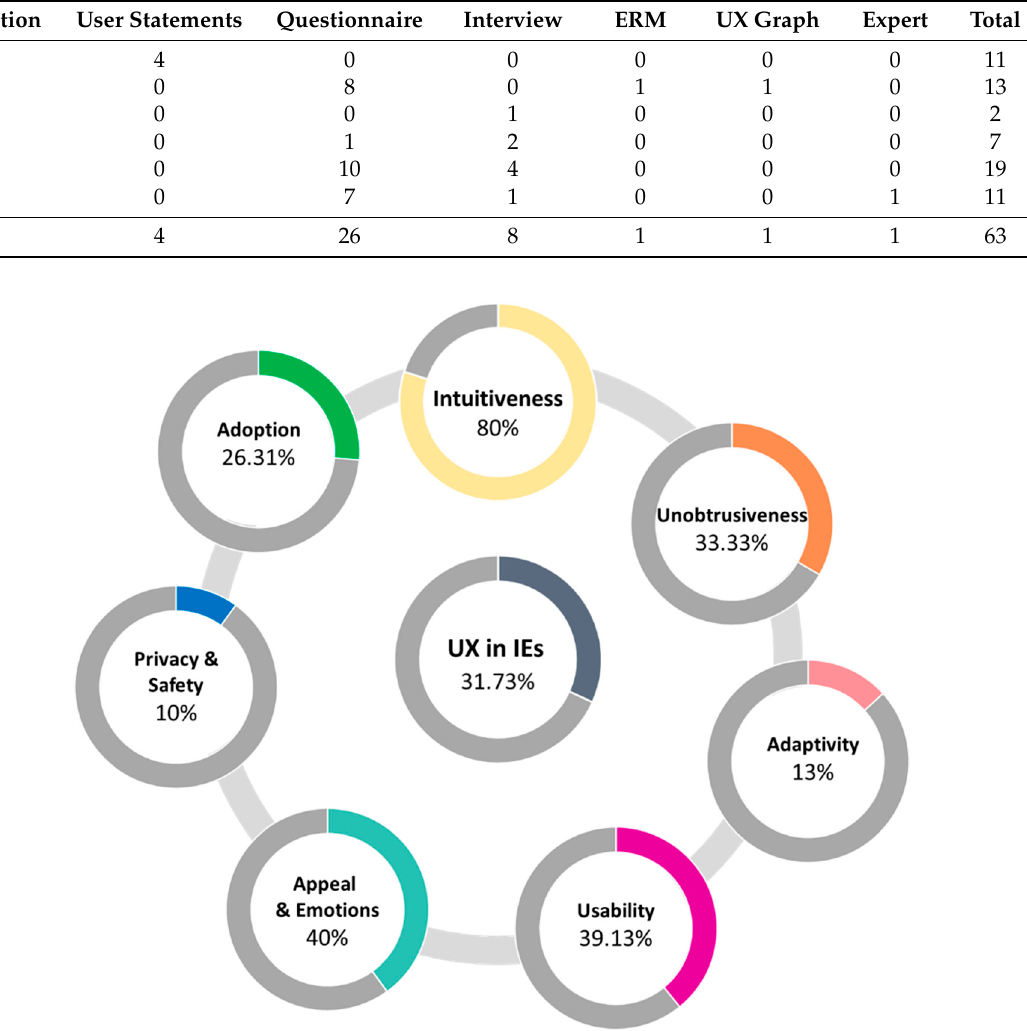
Table 5. Number of metrics proposed per method in phase A.